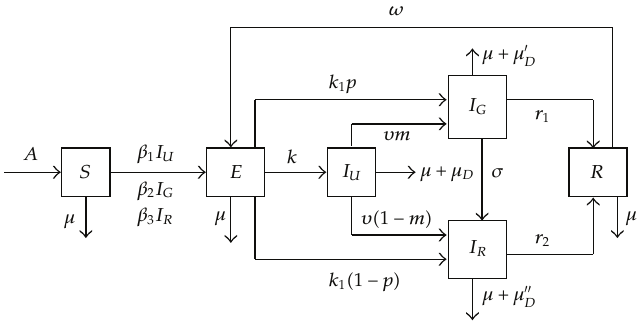
Figure 1: Transfer diagram of the